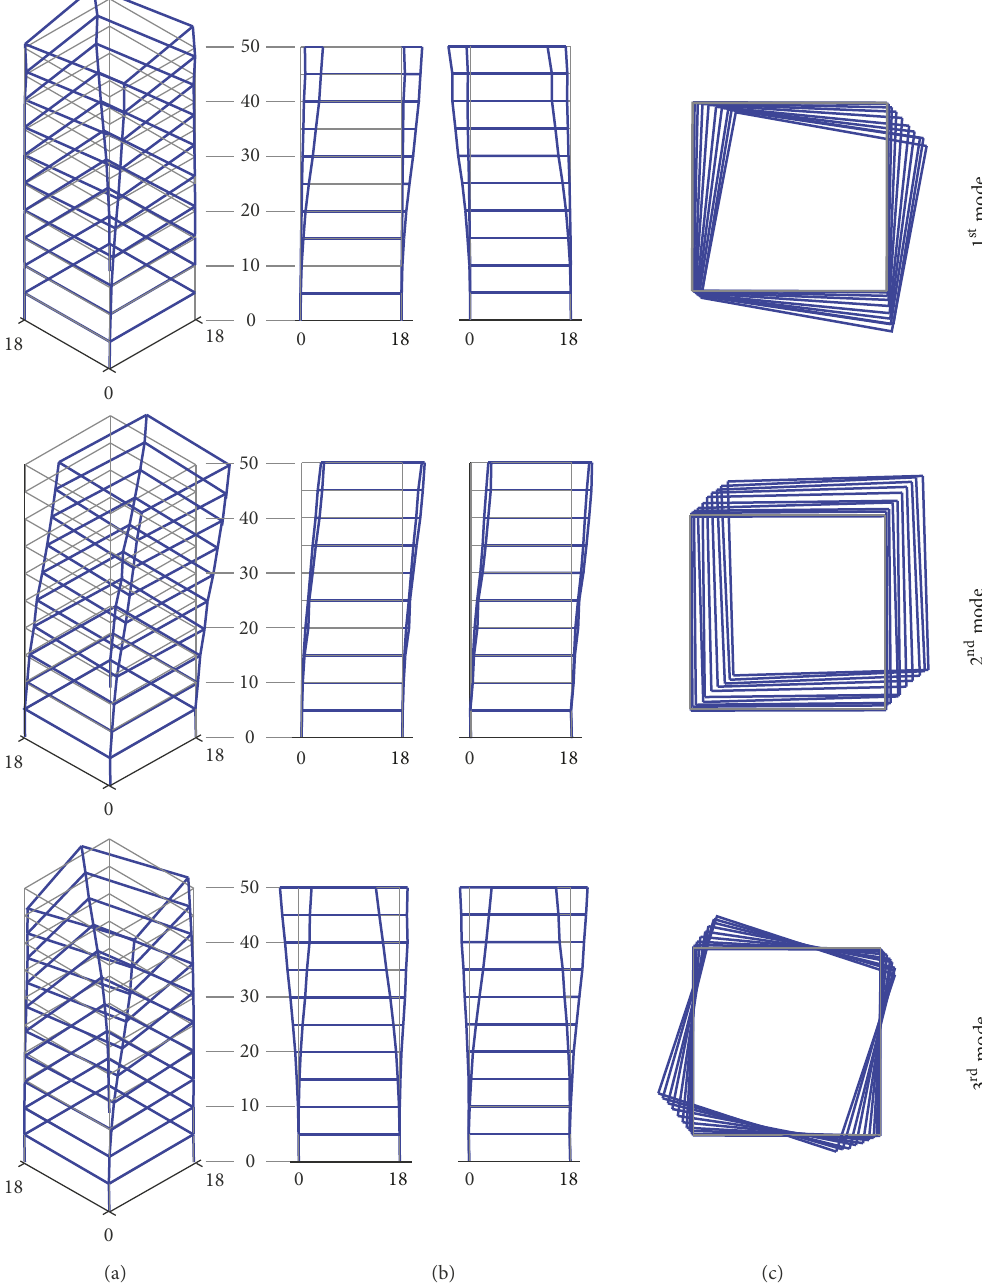
Figure 4: First three global mode shapes of the Tower from AVTs: (a) axonometric view; (b) lateral views; (c) plan